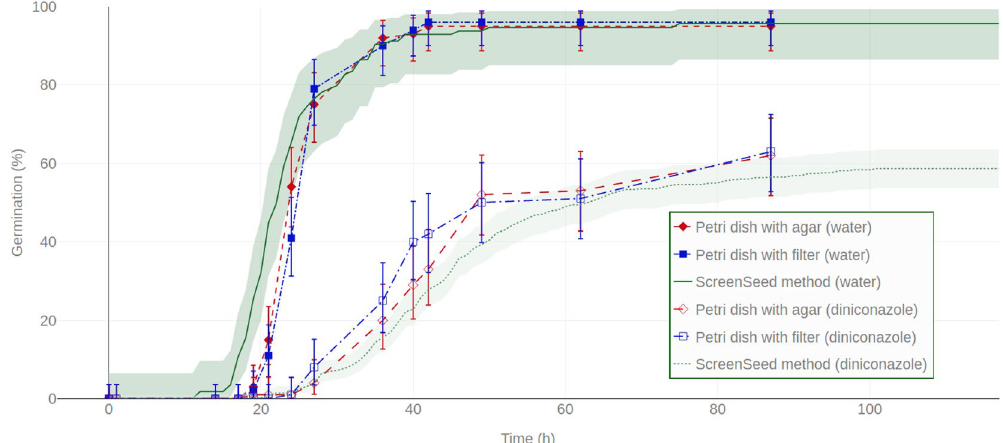
Figure 4. Comparison of seed germination kinetics obtained with the ScreenSeed robot and standard visual- based methods. Germination kinetic curves obtained with ScreenSeed phenotyping tools (line and dots for water and 10 µ M diniconazole conditions respectively) are compared to standard methods (visual monitoring of seed germination) in Petri dishes using filter paper (square) or agar medium (diamonds), in water (filled symbols) or in 10 µ M diniconazole (empty symbols), respectively. Shaded areas around the curves obtained using ScreenSeed technology represent the 90% confidence intervals matching Fisher Exact test as described in 50 . For standard methods by visual scoring in Petri dishes, the average of 4 blocks of replicates is shown with error bars representing the 90% Fisher Exact test confidence interval. As described in Supplementary Data S4 online, 100 seeds have been used for Petri dishes conditions. Regarding observation from the ScreenSeed robot, 55 seeds for the non treated (water) condition and 404 seeds for the 10 µ M diniconazole conditions were observed